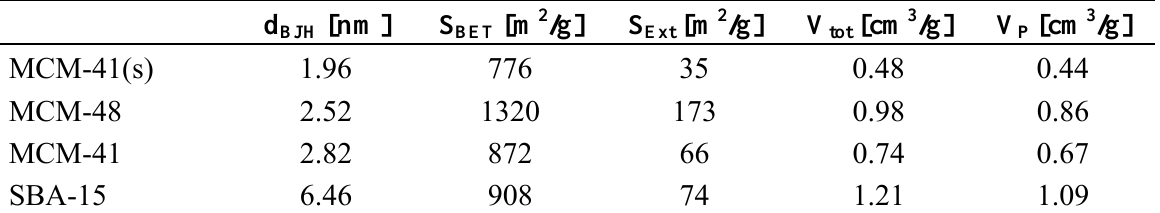
Table 1. Properties of the parent mesoporous silica materials.